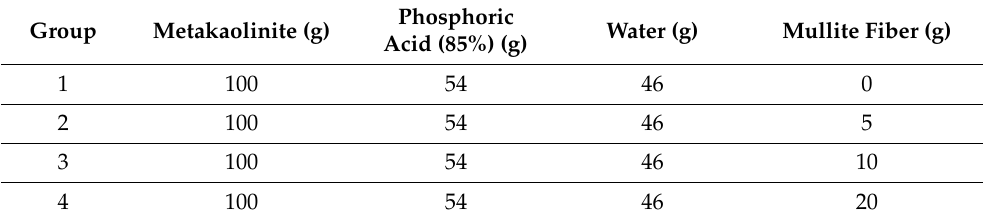
Table 2. Proportion of raw materials used in sample preparation.